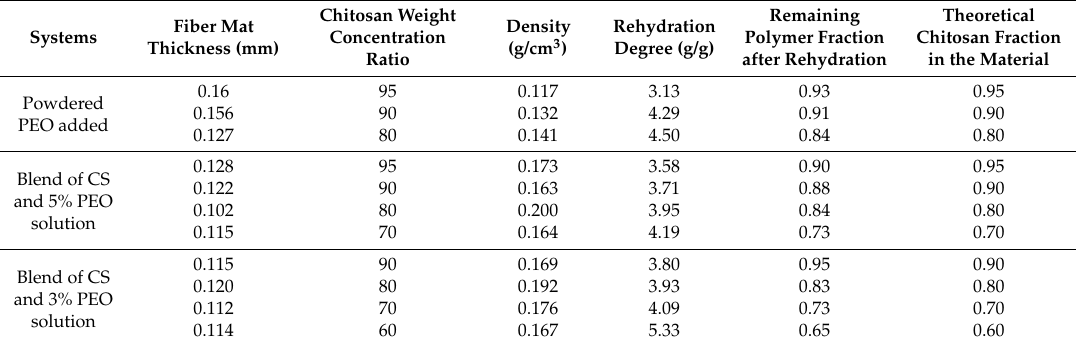
Table 5. Degree of rehydration of nanofibers after neutralization, extraction of PEO ( MW = 5 × 10 6 ) and